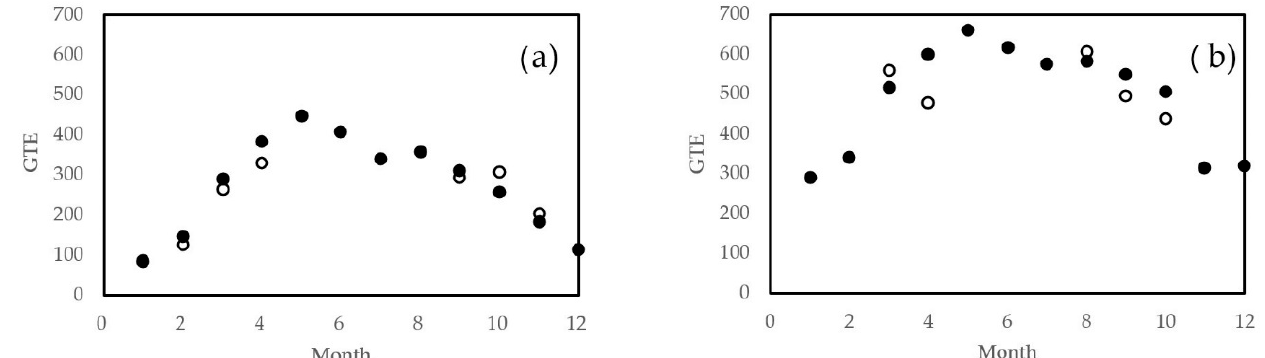
Figure 3. GTE estimated in Chapingo, Mex. ( a ) Measured outside-the-greenhouse temperature (o) and from the Chapingo weather station ( ● ). ( b ) Measured inside-the-greenhouse temperature (o) and simulated temperature with CFD ( ● ).